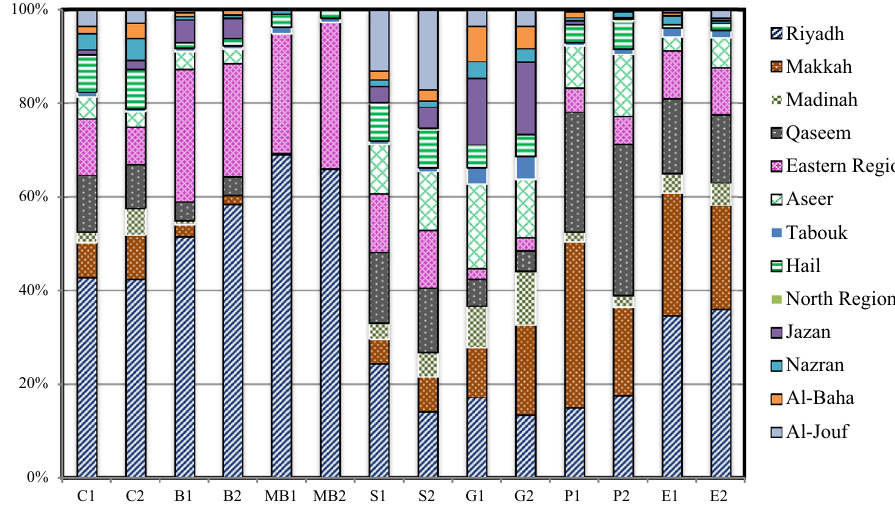
Fig. 1 Percentile distributions of livestock in different regions of Saudi Arabia. C camel, B cow (only for meat production), MB dairy